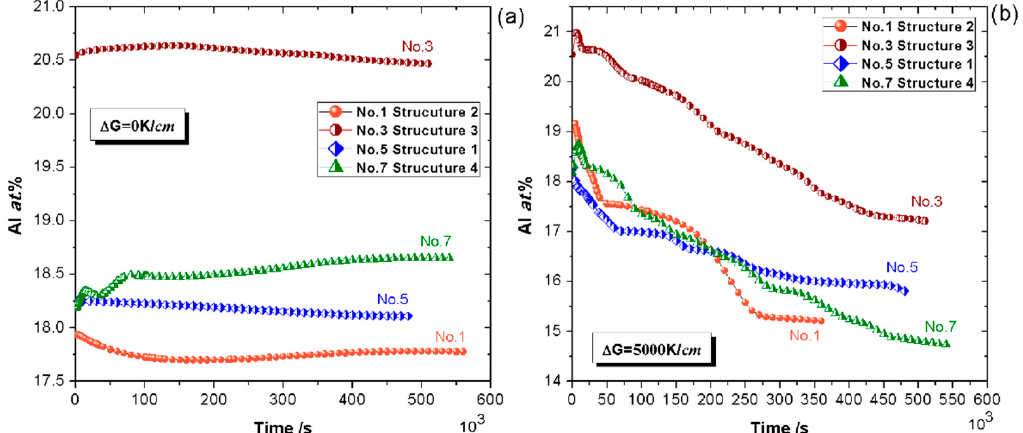
Figure 11. Surface Al concentration evolution of γ / γ ' bond coat annealed ( a ) at constant temperature (1373 K) and ( b ) with the effect of temperature gradient Δ G = 5000 K/cm.